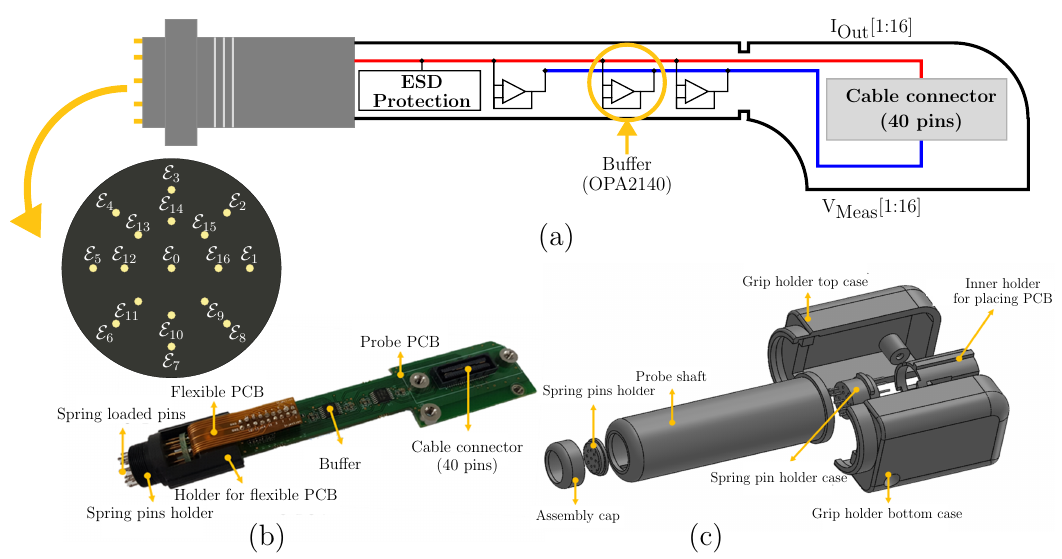
Figure 1. ( a ) The concept diagram of the multiple active electrodes EIS probe. ( b ) Implementation of EIS probe with spring-loaded pins, signal buffers, and printed circuit board (PCB). ( c ) Probe sealing case to protect against